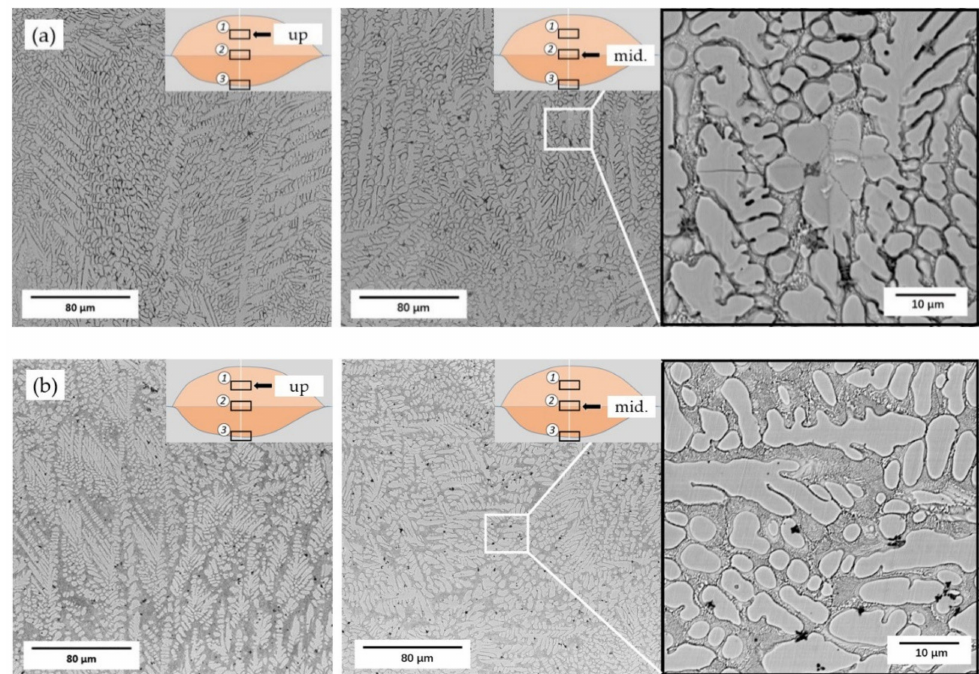
Figure 7. SEM images for upper and middle area microstructure of cladding layer: ( a ) 55 NiTi cladding layer; ( b ) 55 NiTi + 5 Ni cladding layer.